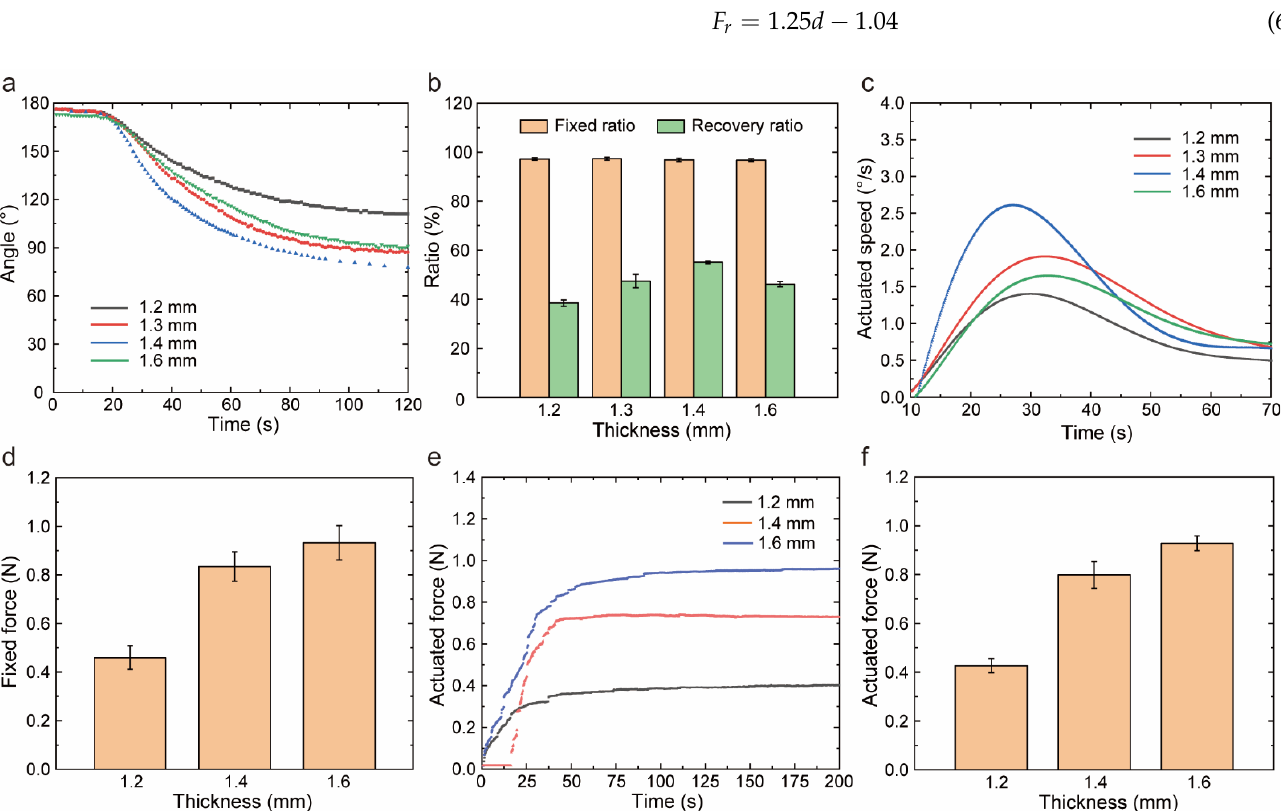
Figure 7. The effect of thickness on shape memory properties and actuation performances. ( a ) The angular recovery for different thicknesses. ( b ) The shape memory properties for different thick- nesses. ( c ) The angular speed for different thicknesses. ( d ) The maximum speed for different thick- nesses ( e ) The fixed force for different thicknesses. ( f ) The recovery force for different thicknesses.